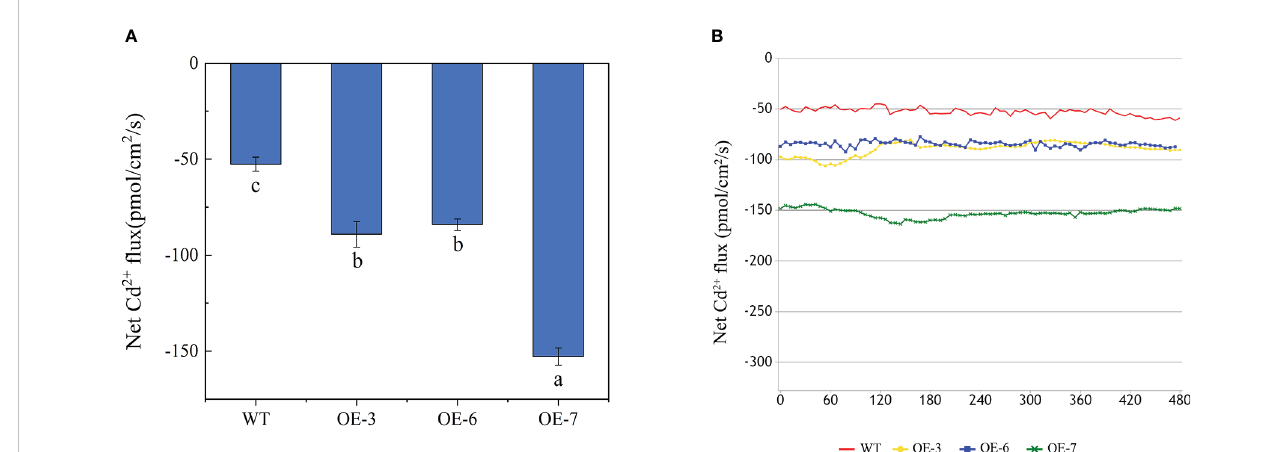
FIGURE 4 Effects of Cd treatments on the Cd 2+ net fl ux in the roots of WT and transgenic lines. (A) Results of the statistical analysis of the steady-state Cd 2+ net fl ux. (B) Time-course of the Cd 2+ net fl ux at the root surface. Different letters on bars indicate signi fi cant differences in the Cd concentrations among lines ( p <